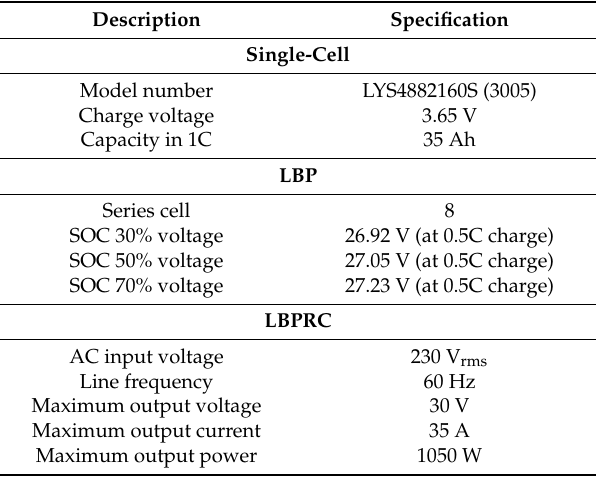
Table 3. Specifications of LiFePO 4 battery and